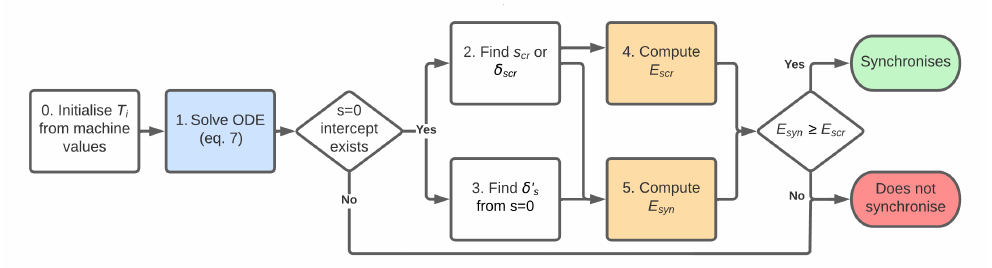
Figure 16. Flowchart implementing the energy method (Chama et